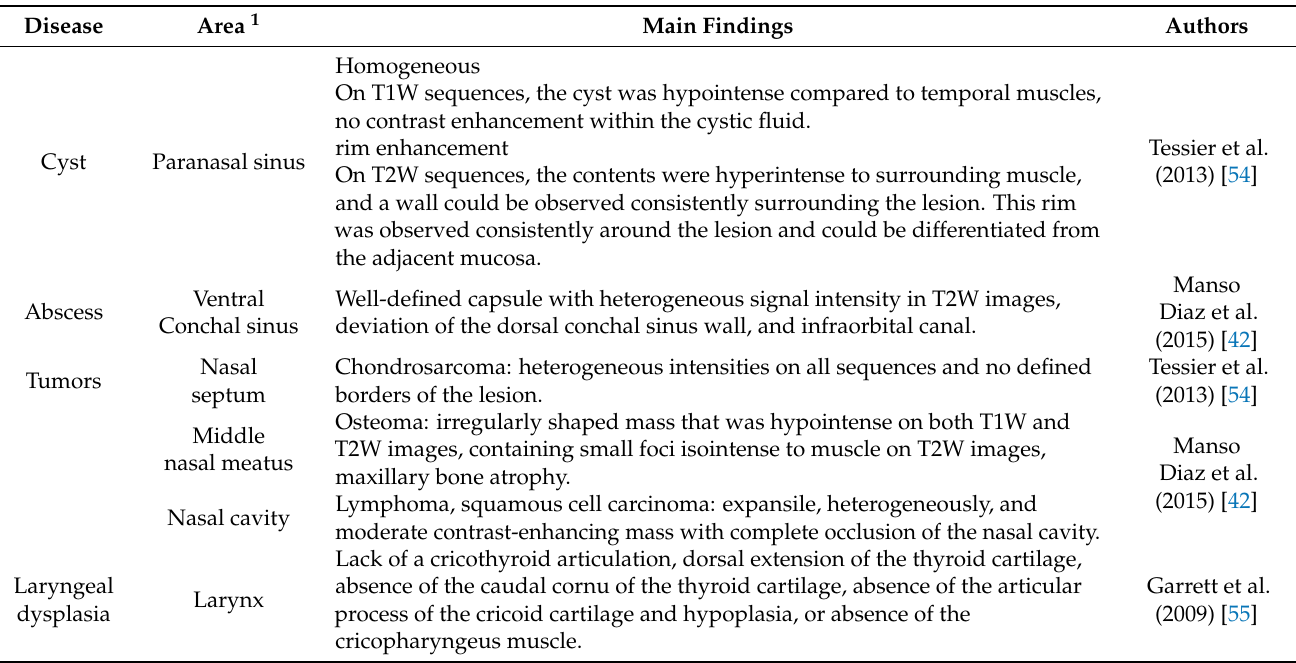
Table 2. The selected diseases of the equine head and neck area and their main findings diagnosed based on magnetic resonance